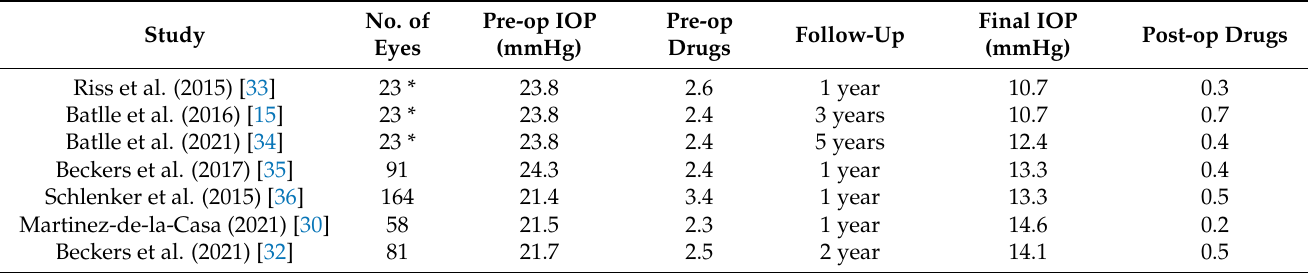
Table 1. PreserFlo results in different studies, with average values reported from each research. IOP = intraocular